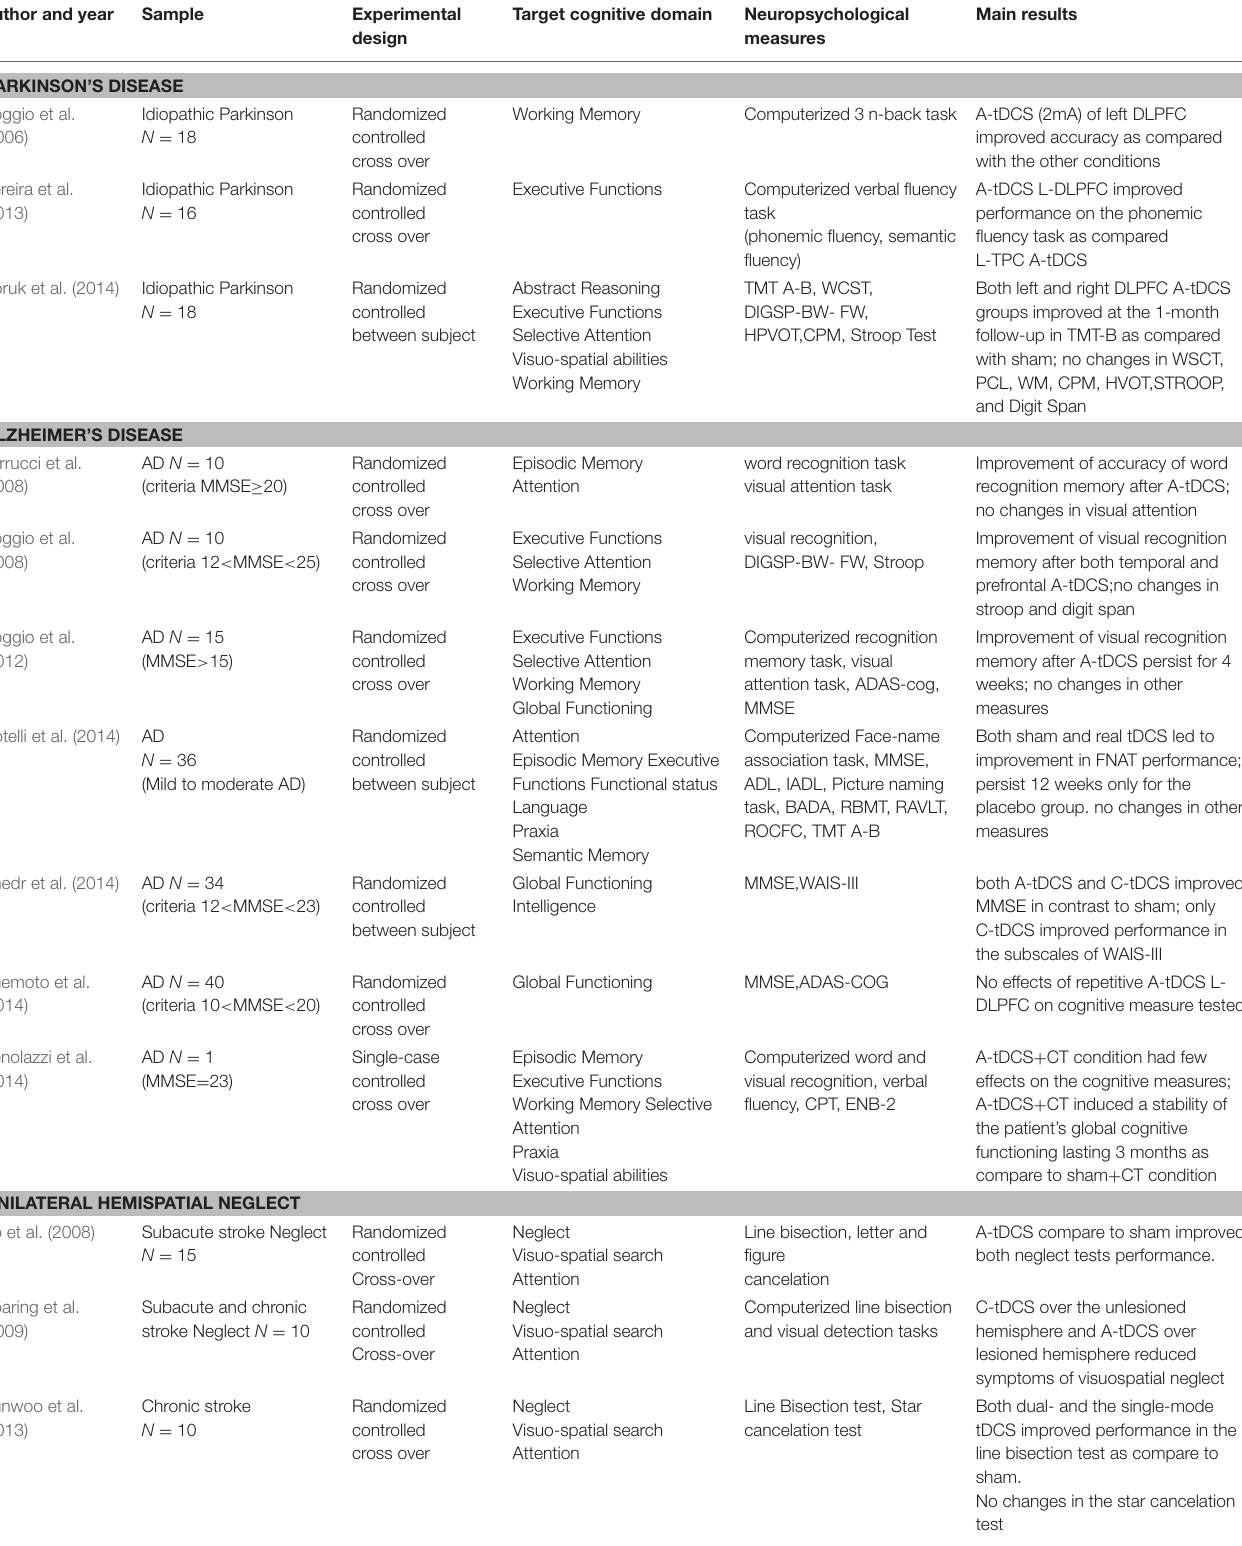
TABLE 2 | Patient characteristics, experimental design, cognitive domains, tasks used as outcome measures and main results of studies which used tDCS for cognitive rehabilitation in Parkinson’s disease, Alzheimer’ disease, unilateral neglect, or